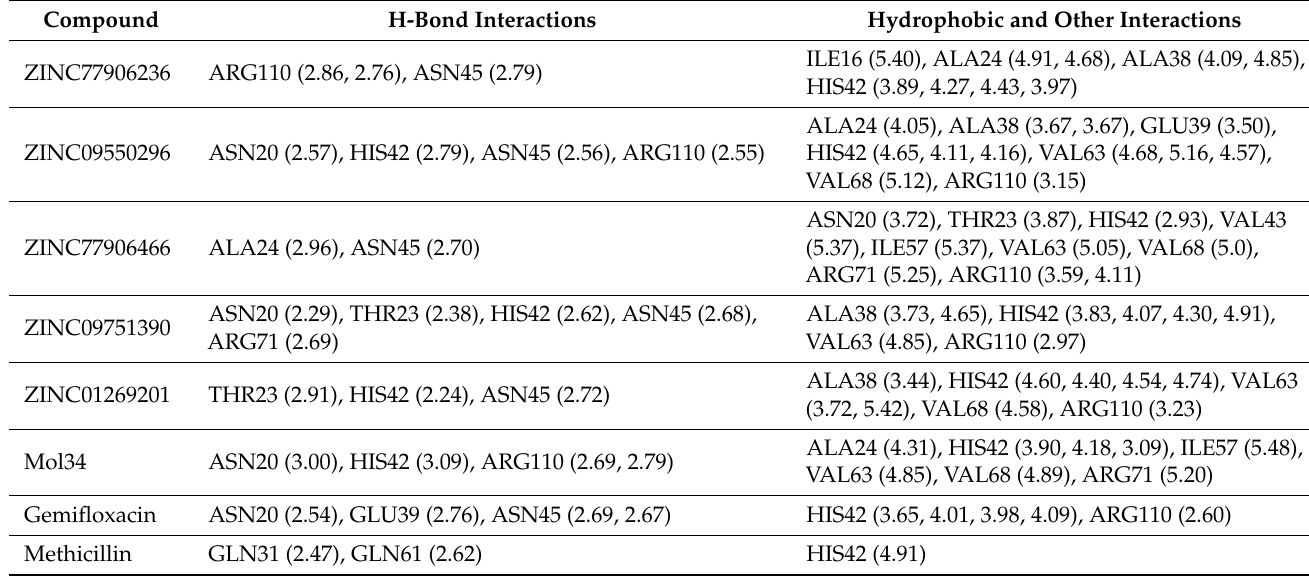
Table 3. The intermolecular interactions of hit compounds and gemifloxacin in the active site of S. epidermidis TcaR. The corresponding bond lengths (Å) are shown in parenthesis. Compound H-Bond Interactions Hydrophobic and Other